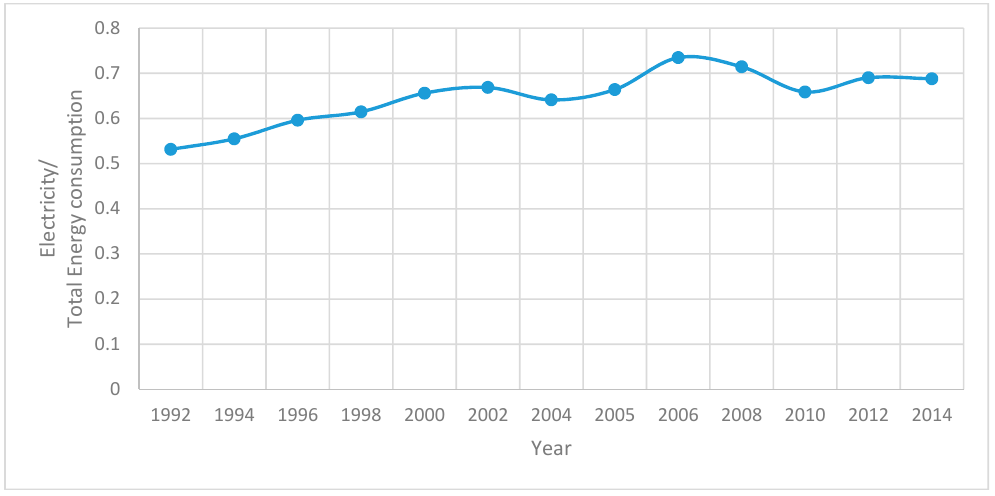
Figure 4. Electricity/total energy consumption ratio. Mexico 1992–2014. Source: Authors’ calculations, ENIGH (1992–2014).